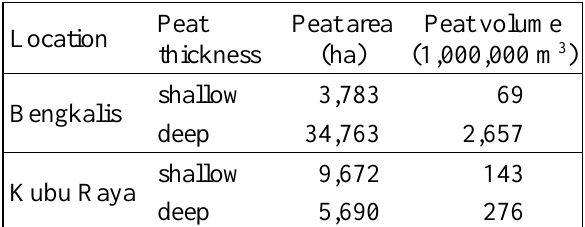
Table 1. Average elevation (m above MSL) of the peat base with shallow peat (0.4–3.0 m thick) and deep peat (> 3.0 m thick) in soil cores.